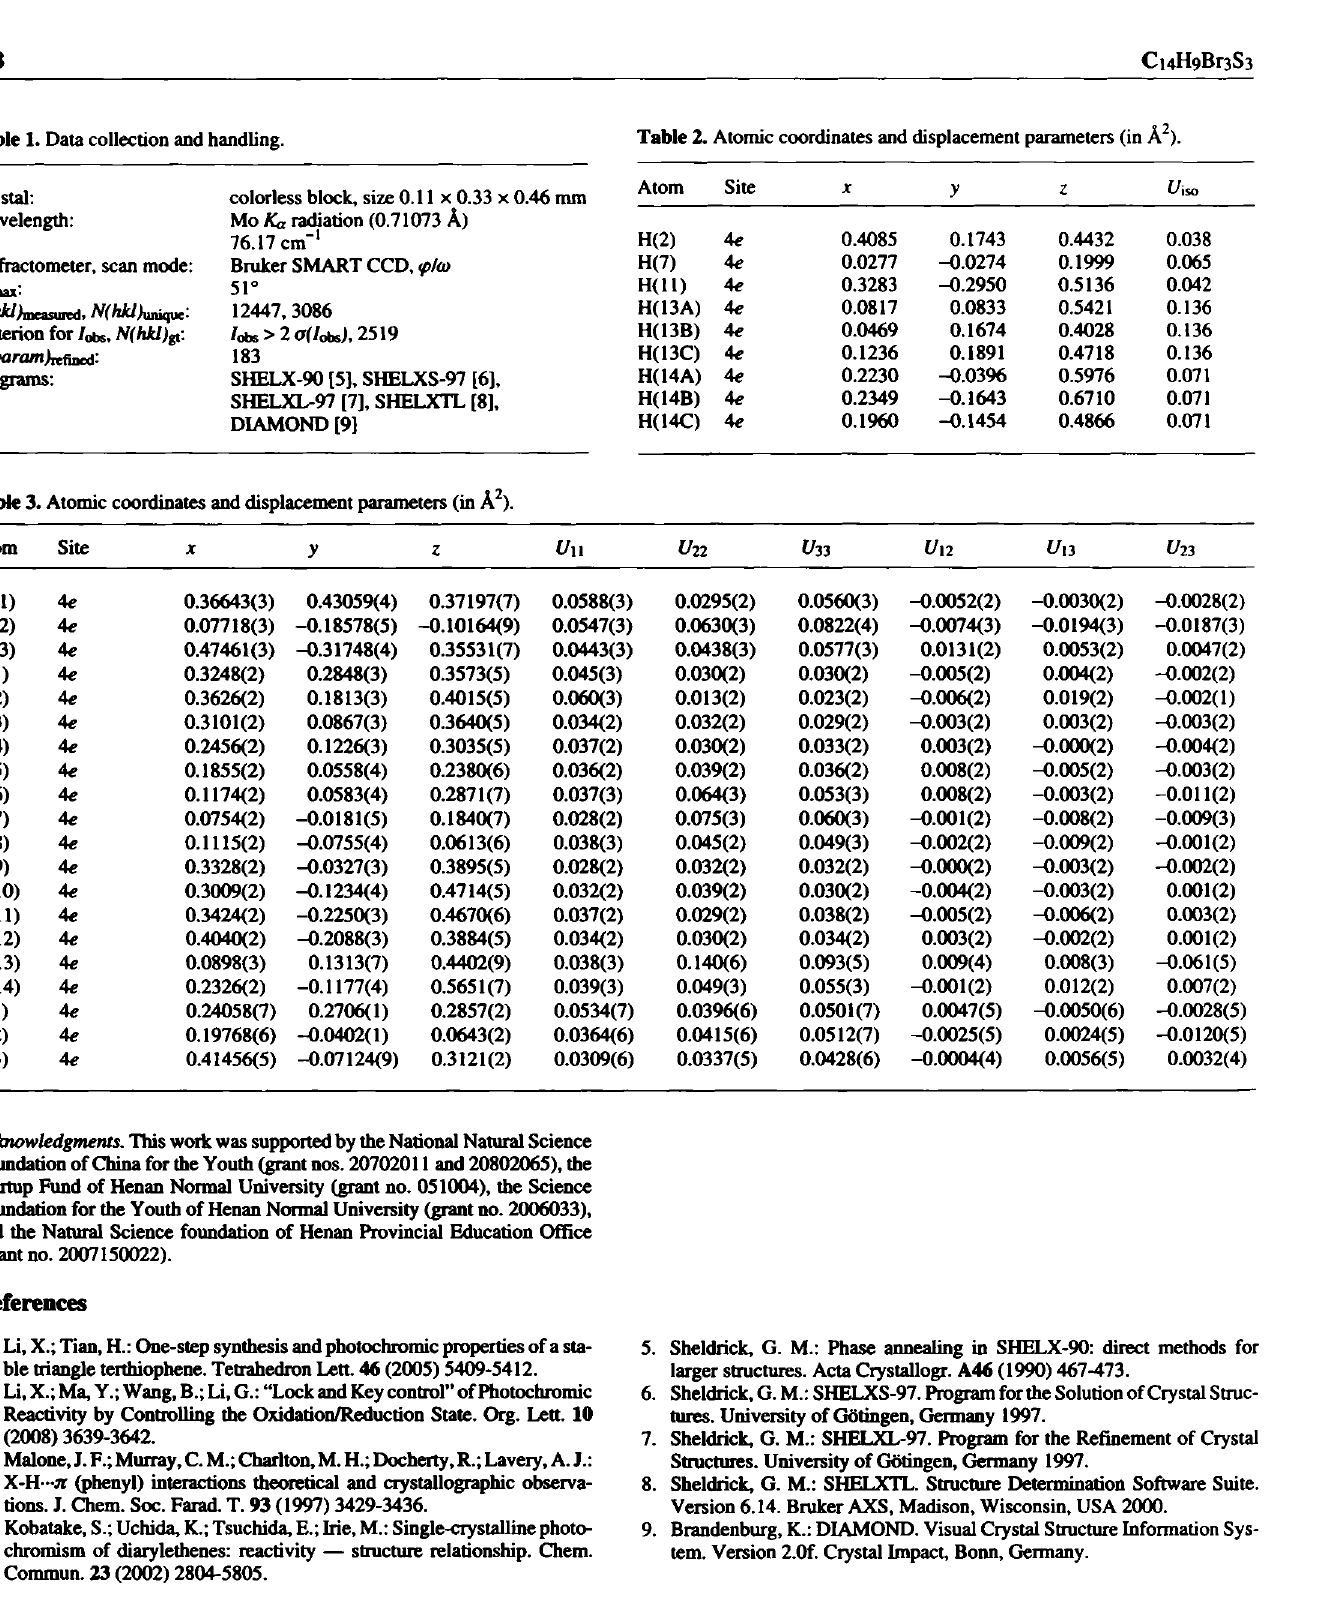
Table 1. Data collection and handling. Table 2. Atomic coordinates and displacement parameters (in Â 2 ).